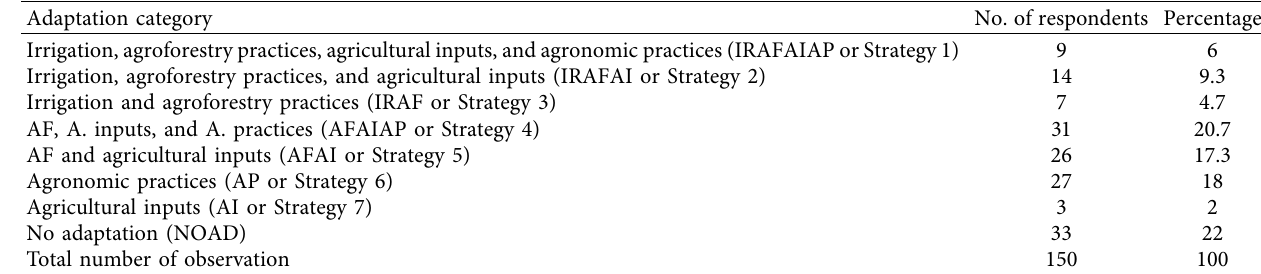
Table 5: Categorized adaptation strategy used by farmers.